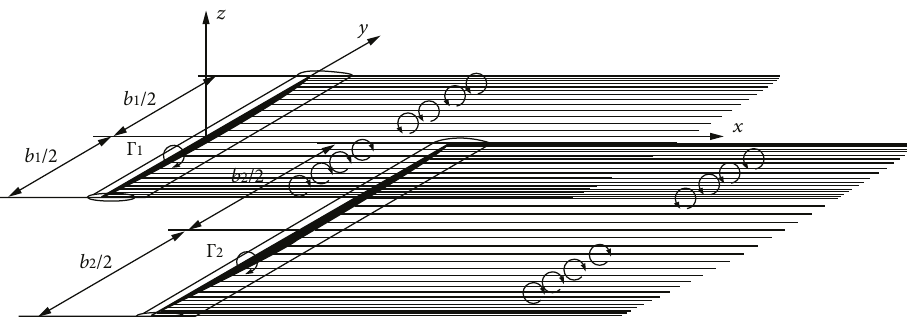
Figure 1: Prandtl ’ s model for the bound vorticity and the trailing vortex parallel to the x -axis generated by tandem wings.